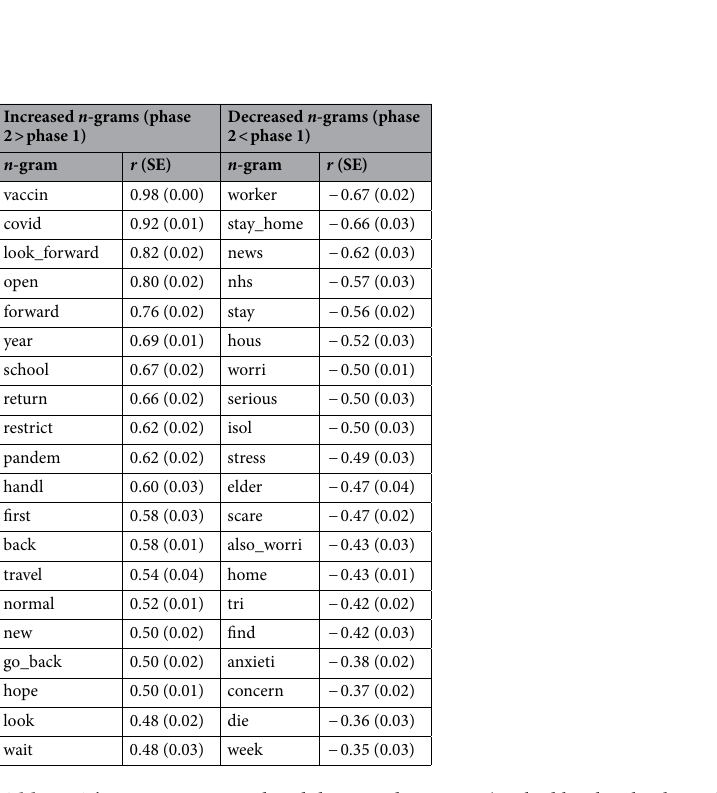
Table 8. The top 20 increased and decreased n -grams (ranked by the absolute effect size r